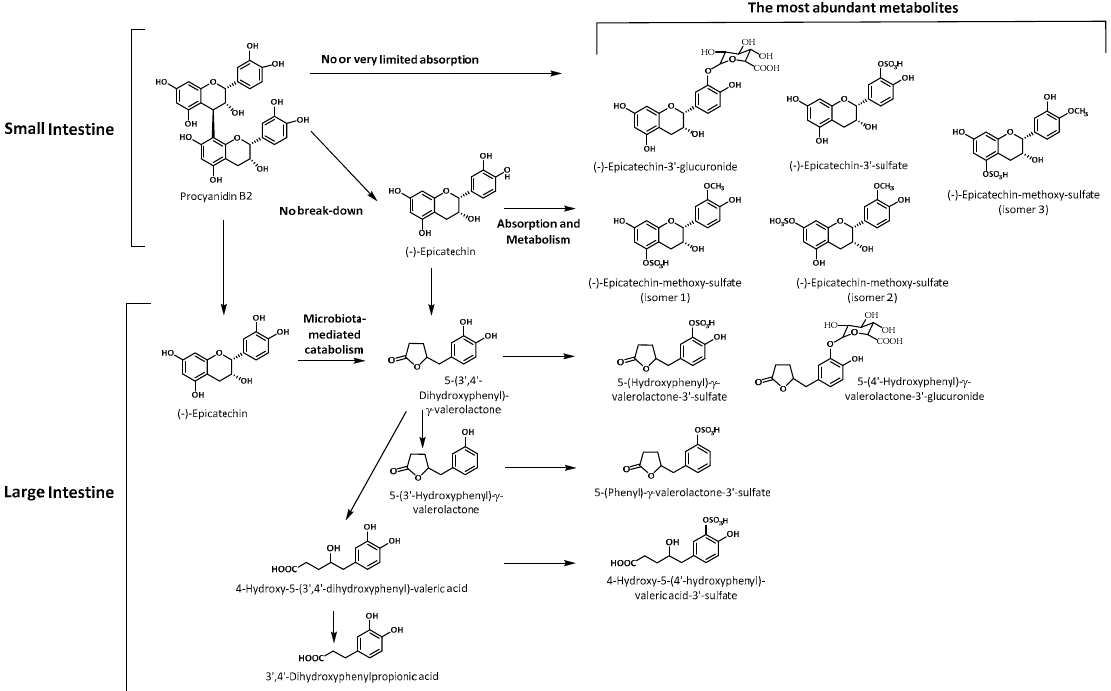
Figure 2. Biotransformation pathways in humans of the main flavanols contained in a conventional soluble cocoa product (CC) and a flavanol-rich soluble cocoa product (CC-PP).